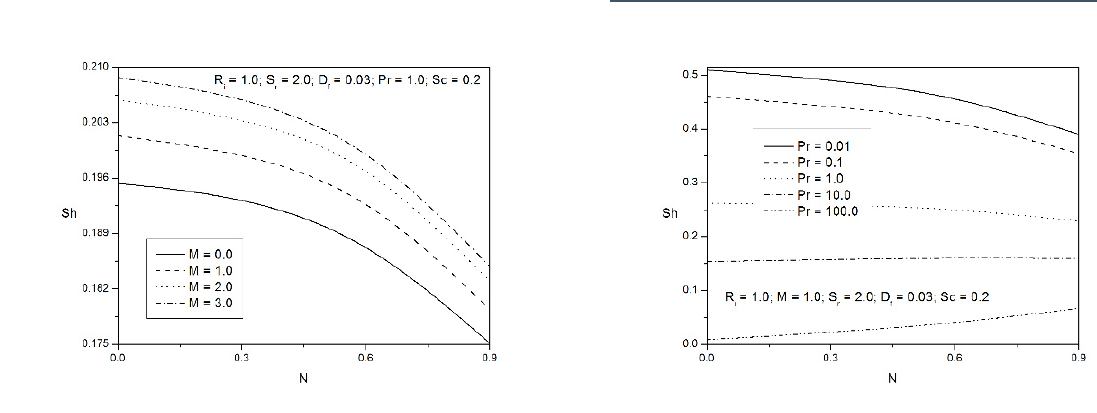
Figure 11. Effect of Prandtl number Pr on Mass Transfer Rate